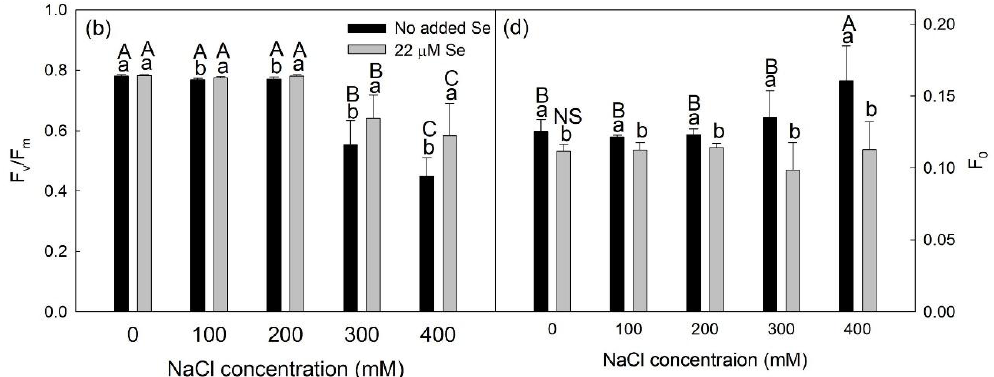
Figure 2. Images and the mean ± SD ( n = 4) of the maximum quantum yield of photosynthetic system II (F v / F m ) ( a , b ) and the minimal fluorescence of photosynthetic system II (F 0 ) ( c , d ) of leaves collected Figure 2 from untreated seedlings (No added Se) and Se-treated seedlings (22 µ M Se) under di ff erent NaCl concentrations. The false color code depicted on the top of the images ranges from 0.0 (black) to 1.0 (purple). Values followed by di ff erent letters statistically significantly di ff er at p < 0.05. Means with di ff erent lowercase letters significantly di ff er by a t -test between Se treatments (No added Se and 22 µ M Se) at the same NaCl concentration. Means with di ff erent capital letters significantly di ff er by an LSD test under di ff erent NaCl concentrations in separate untreated and Se-treated groups ( p <